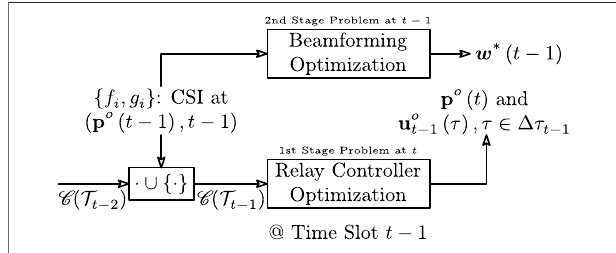
FIGURE 1 | 2-Stage optimization of beamforming weights and relay motion controls. The variable w * ( t − 1 ) denotes the optimal beamforming weights, selected at time slot t − 1.